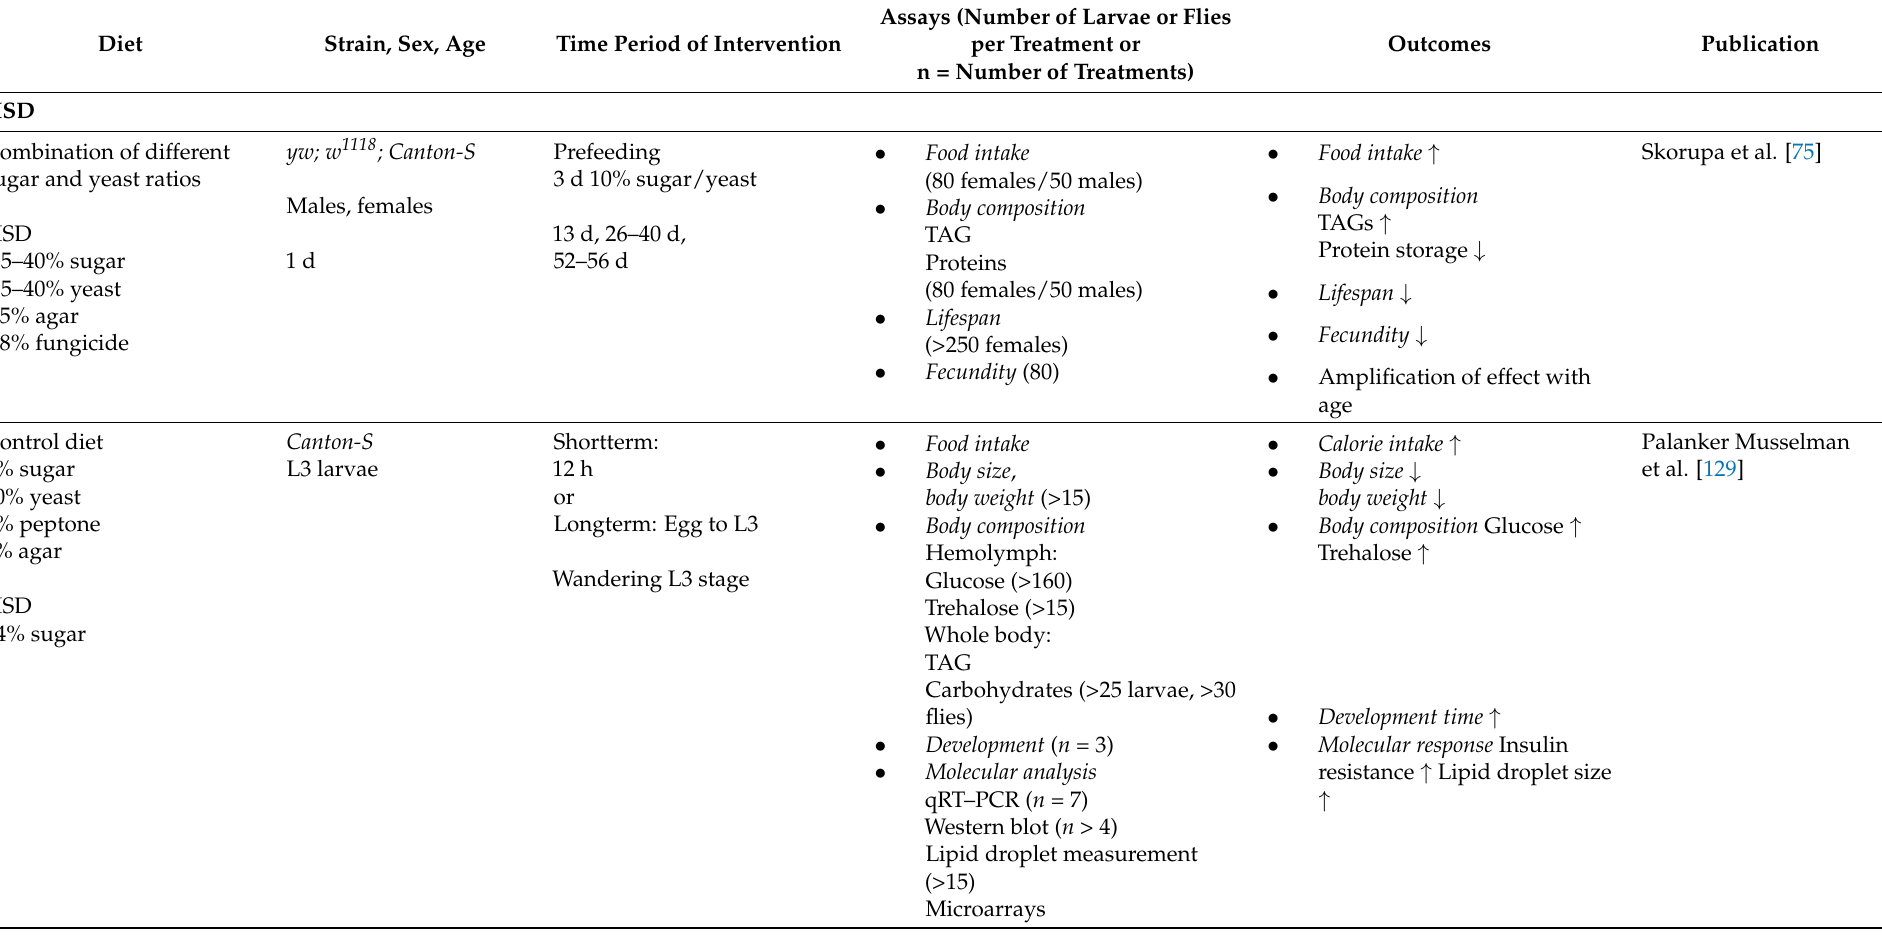
Table 3. Overview of dietary intervention studies regarding high-sugar diet (HSD) or high-fat diet (HFD) feeding in Drosophila melanogaster . The studies are ordered by release